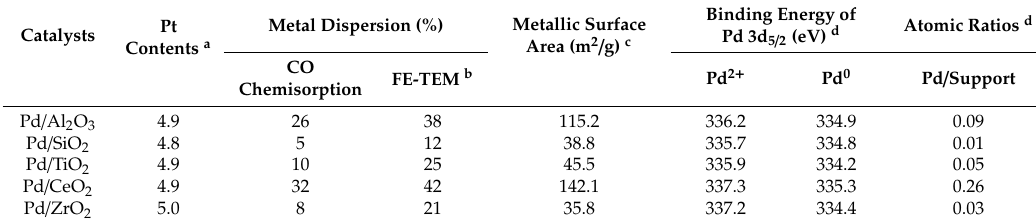
Table 2. Characterization of Pd